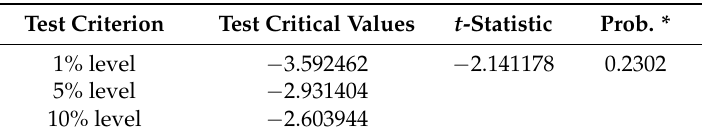
Table 1. Augmented Dickey–Fuller (ADF) statistic